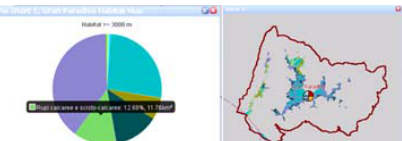
Figure 11. Pie chart for the Gran Paradiso Natural Park Habitats over 3000 m.